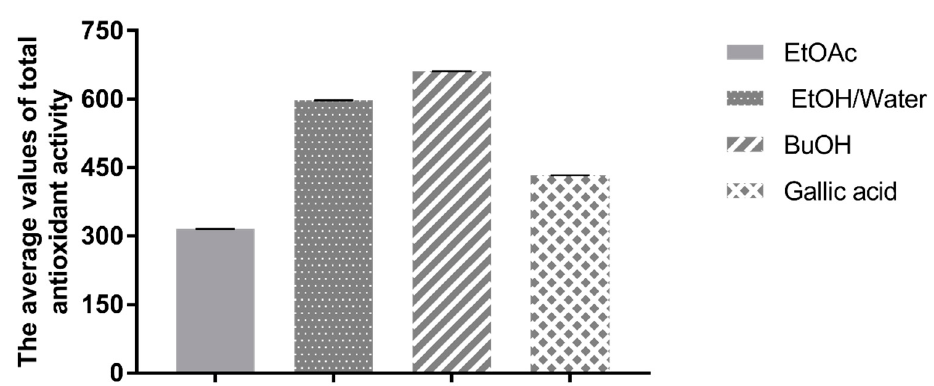
Molecules 2021 , 26 , x FOR PEER REVIEW